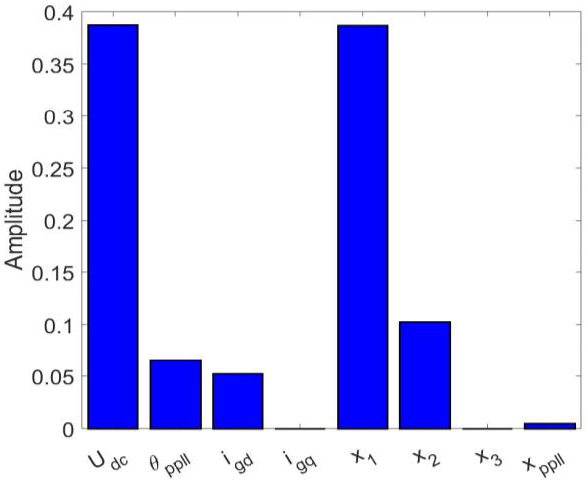
Figure 9. Participation factors of SSR modes with k p 2 = 2.